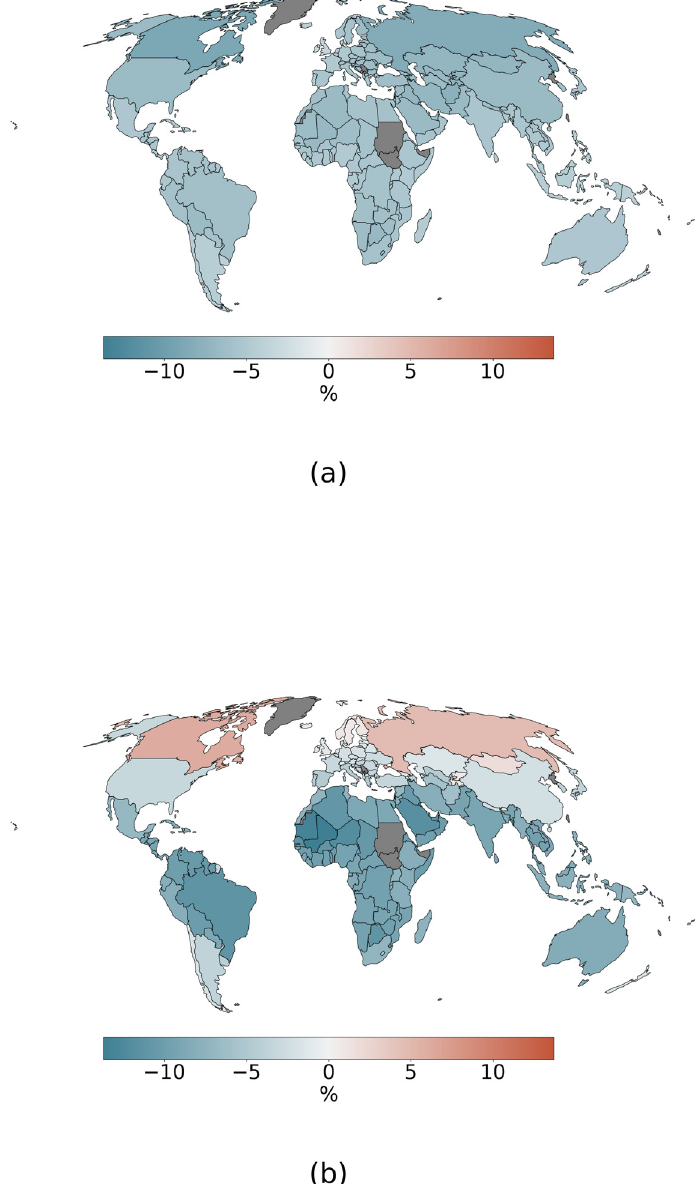
Fig 2. Migration-hump function and GDPc distribution for SSP5–8.5. The upper panel shows the emigration hump function for the T0 assumption (black line), as described in Eq 8, and its shifted version for the TS assumption (dashed line), as described by Eq 10. We show for one country its location on both these curves and its location when considering the CR assumption (blue dot). Grey area represents the extremes reached by the migration hump function when considering the parameter b G on its values at 66% confidence interval. The middle panel shows the population weighted GDPc distribution, for the baseline SSP5, for both climate change impact methods and for the CR assumption. Population and GDPc are averaged for the 30-years period of 3˚C global warming and over the climate models dimension. The bottom panel shows the same as the middle panel but for the number of countries instead of the population. When considering the constant emigration rate case (blue) we use the mean GDPc distribution for the historical period (1990–2015). We calculate bilateral migration flows using baseline and impacted GDPc trajectories under different scenarios, climate models and emigration rates assumptions. Flows cover a 30-years period (see Methods) and are then averaged on both, time and climate models dimension. For each scenario and emigration rate assumption we compare averaged migration flows produced using the impacted GDPc trajectory to those using the baseline